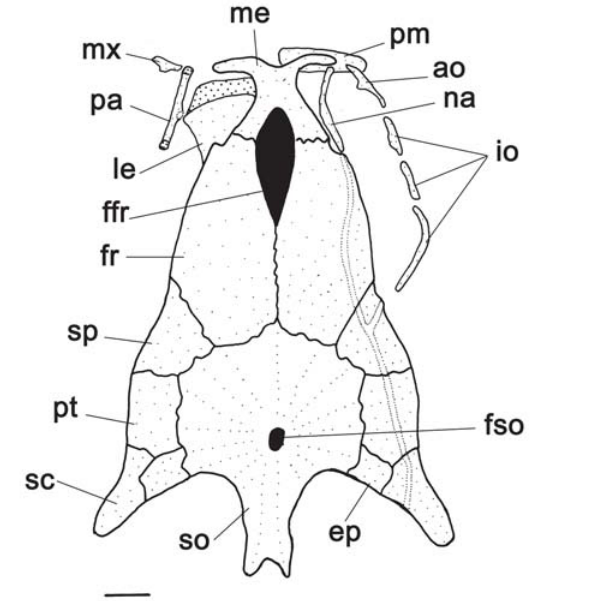
Fig. 4. Cranium of Microglanis pataxo , MNRJ 28398, paratype. Dorsal view. Abbreviations: ao, antorbital; ep, epioccipital; fr, frontal; ffr, frontal fontanell; fso, parieto-supraoccipital fon- tanel; io, anterior, middle and posterior infraorbitals; le, lateral ethmoid; mx, maxilla; na, nasal; pa, autopalatine; pm, premax- illa; pt, pterotic; sc, posttemporosupracleitrum; so, parieto- supraoccipital; sp, sphenotic. Scale bar, 1